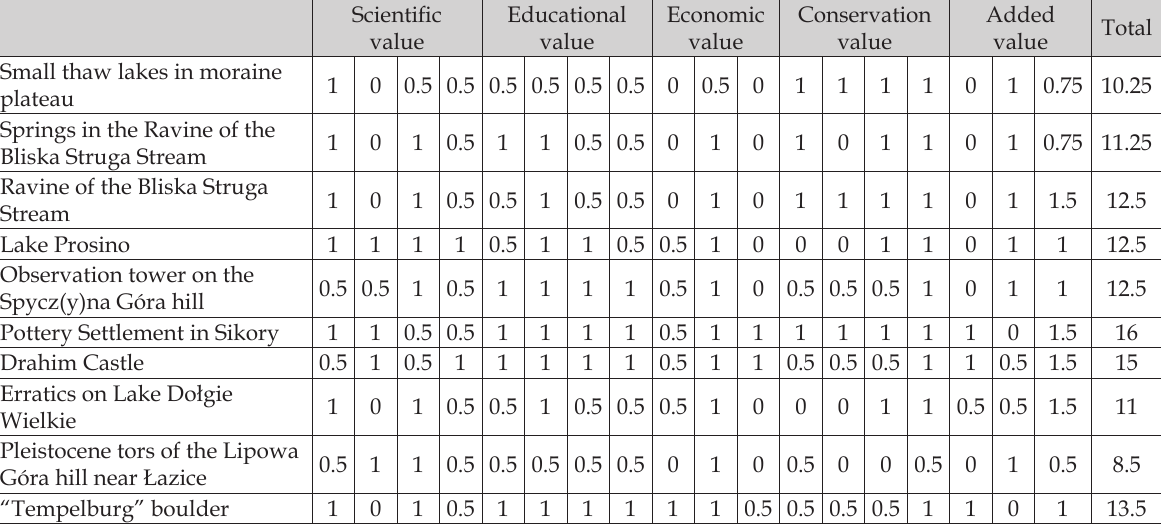
table 3. assessment of selected geosites in the Drawskie lake District concerning the scientific, educational, economic, conservation and added